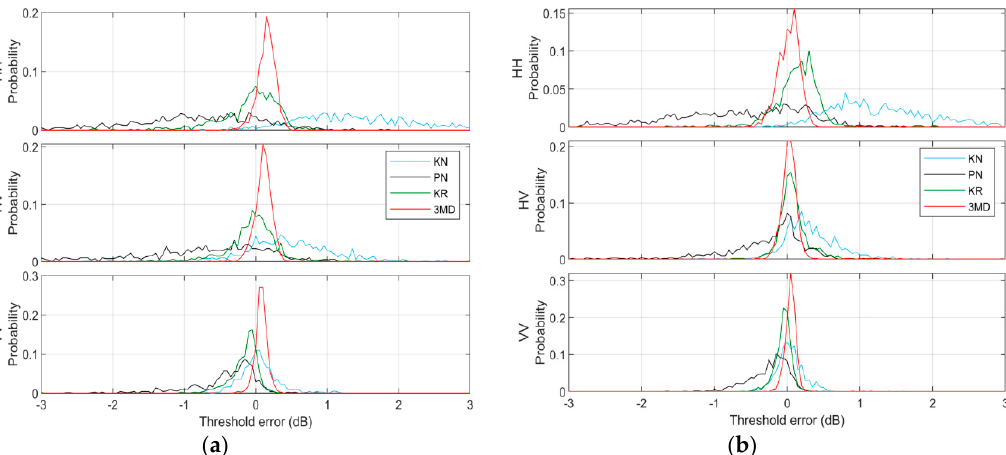
Figure 16. Threshold error histograms for INGARA Runs 3 and 9. Threshold error is measured at a CCDF of 10 − 4 . ( a ) Run 3, ( b ) Run 9.